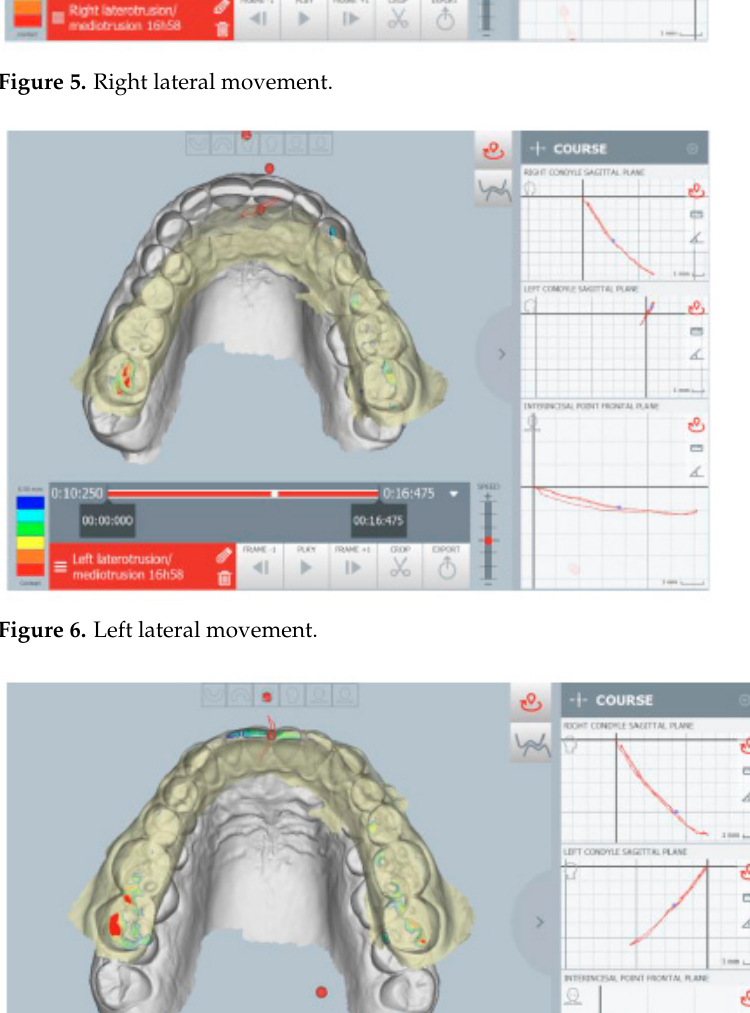
Figure 7. Occlusal contacts during mandibular protrusion movement. The red points indicate an abnormal contact during protrusion.